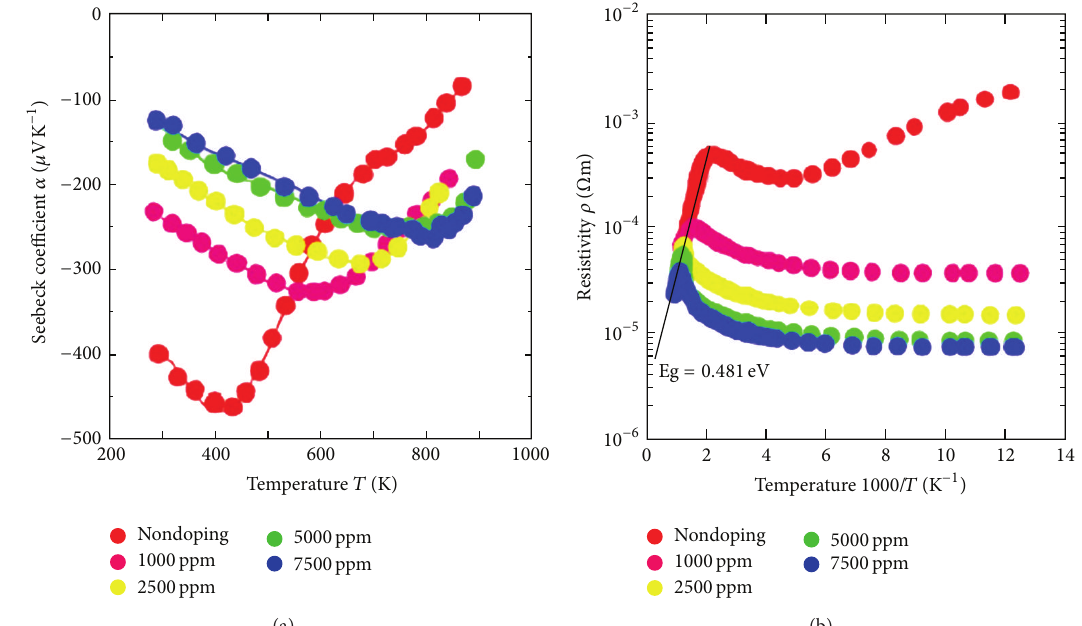
Figure 7: Seebeck coefficient and resistivity as a function of the doping level [65].